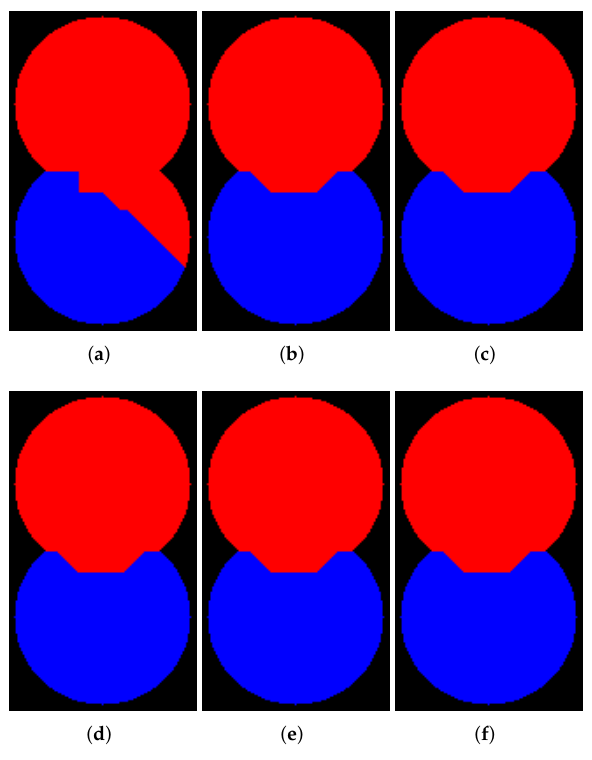
Figure 6. Results of segmentation via watershed without WL (8-connectivity): ( a ) ImageJ; ( b ) ITK; ( c ) Mahotas; ( d ) Mamba; ( e ) Scikit-image; ( f )